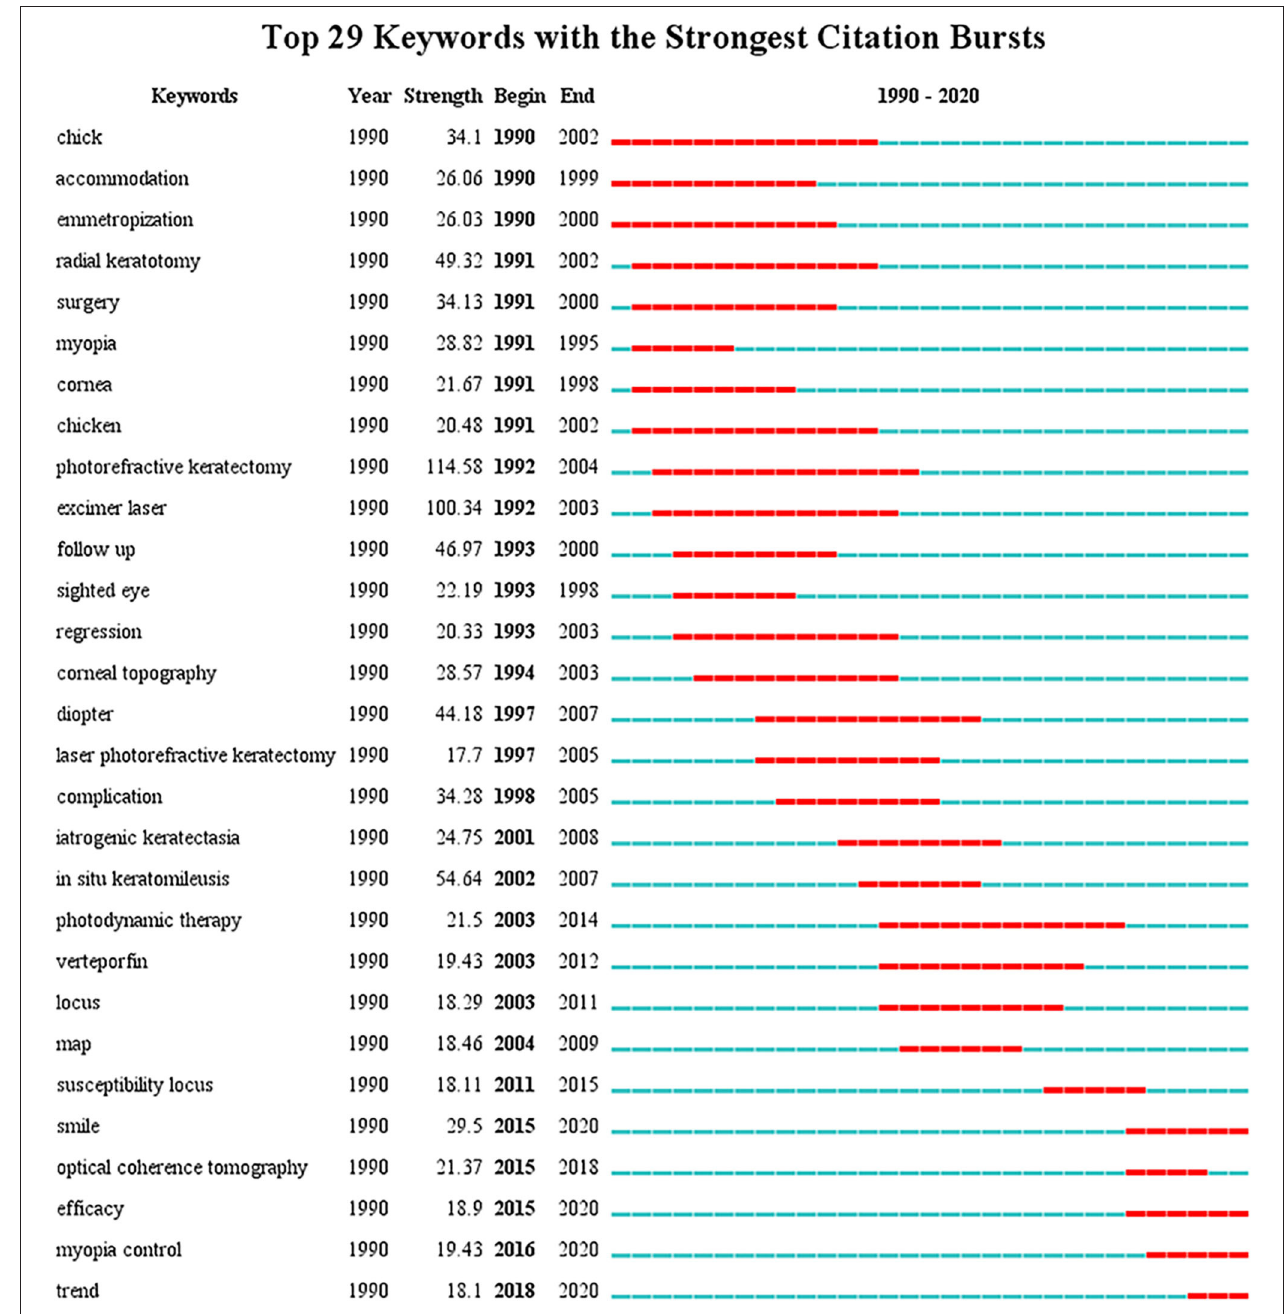
FIGURE 3 | The top 29 keywords with the strongest citation bursts in myopia research from 1990 to 2020. The blue lines represent the base timeline, while the red segments represent the burst duration of the keywords.